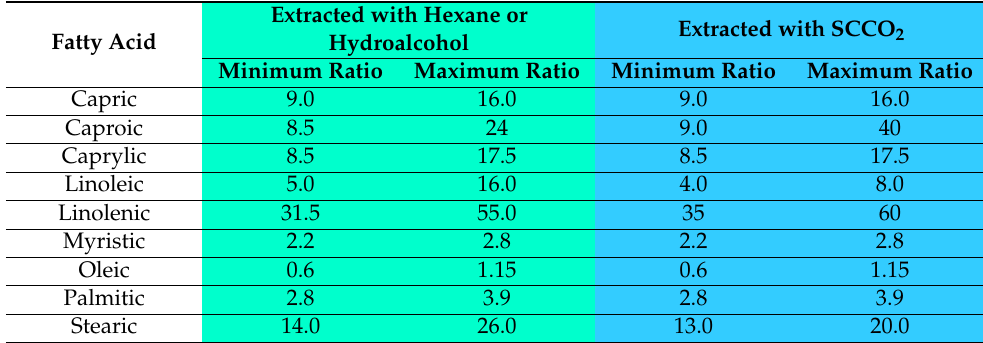
Palmitic LSESr — lipidosterolic extract of Serenoa repens ; SCCO 2 — supercritical carbon dioxide; USP — United States Pharmacopeia. The ranges for ratios of the concentration of lauric acid to the concentration of the respective fatty acid. The USP defines an effective LSESr as having ≥80% free fatty acid content